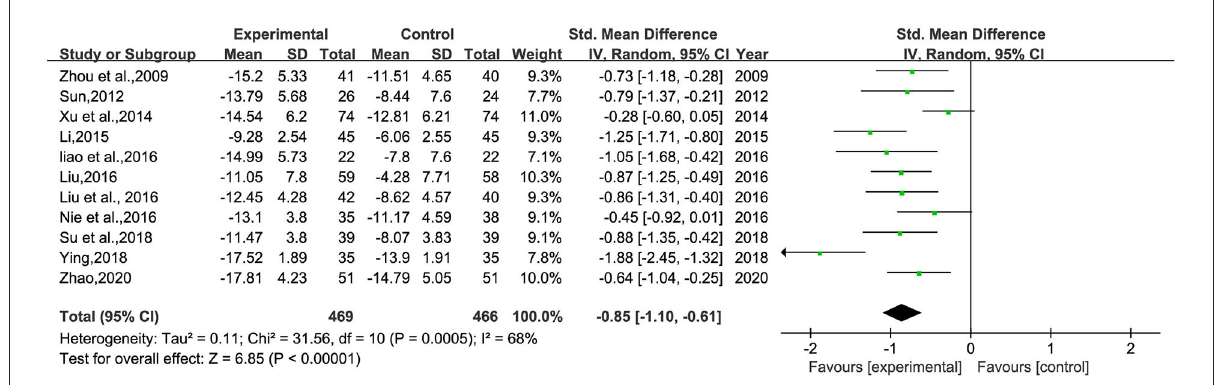
FIGURE3 Meta-analysis of 1-session BHD and HAMD change values of antidepressant drugs. Green: Continuous.